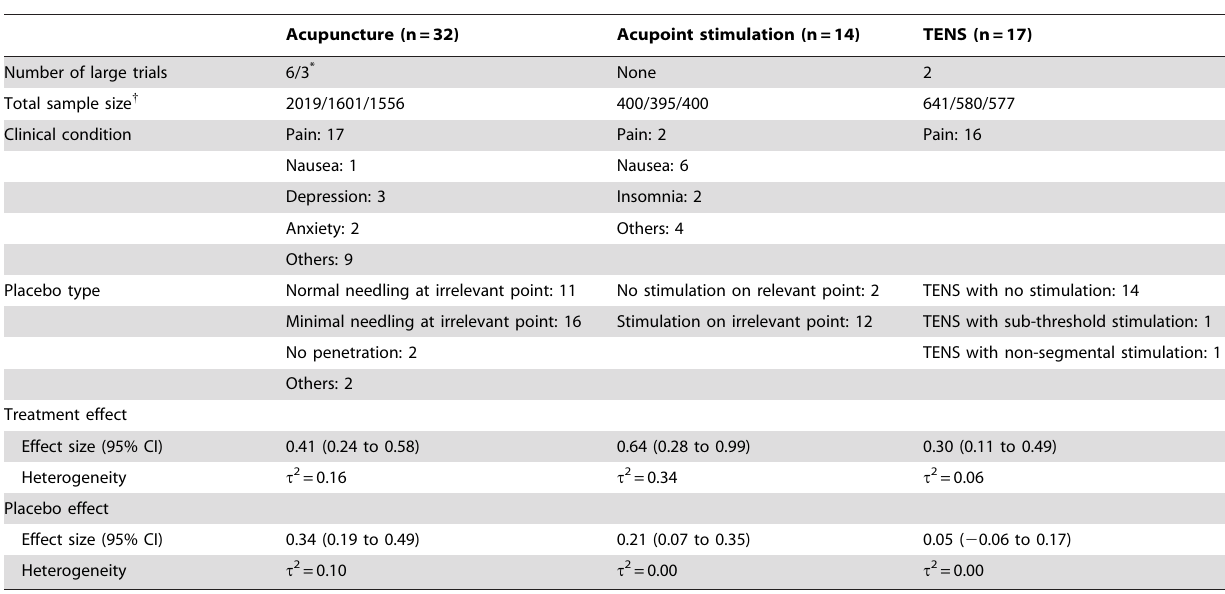
Table 1. Characteristics of trials with continuous outcomes.